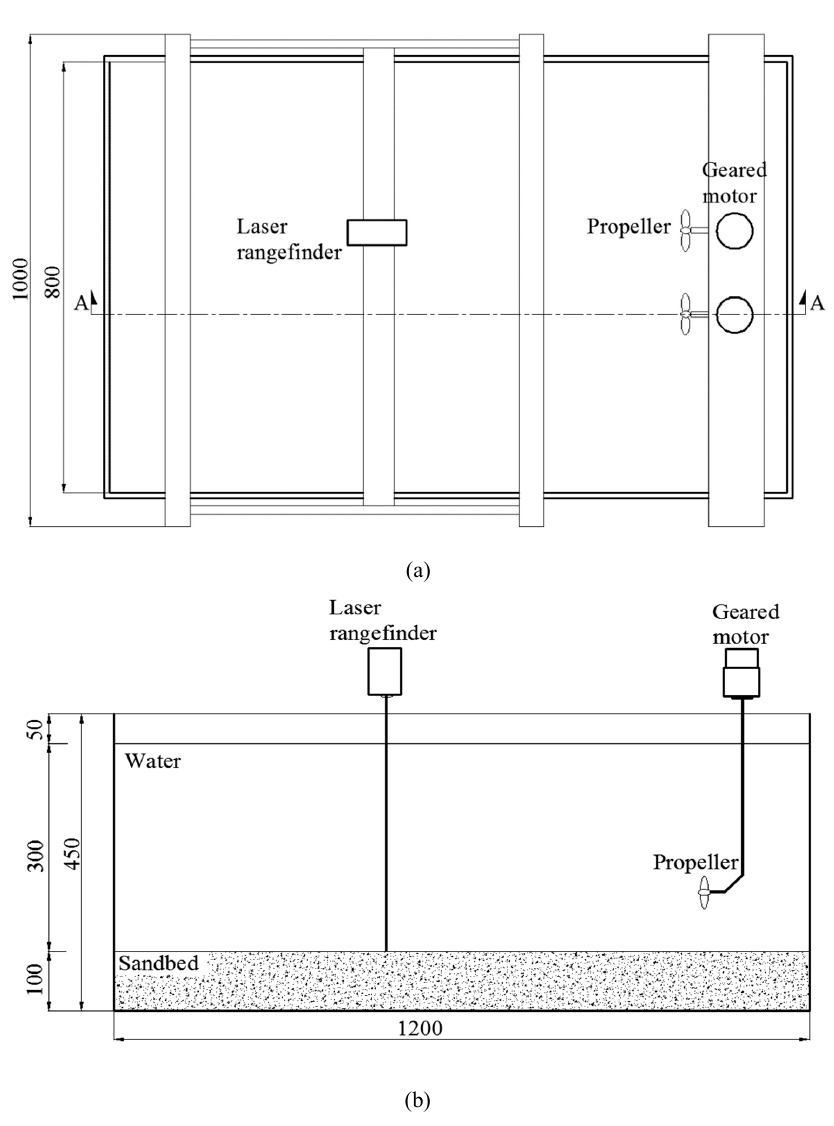
Figure 2. Schematic diagram of the experiment (1.2 m × 0.8 m × 0.45 m). ( a ) Plan view; ( b ) longitudinal cross-section (A-A).